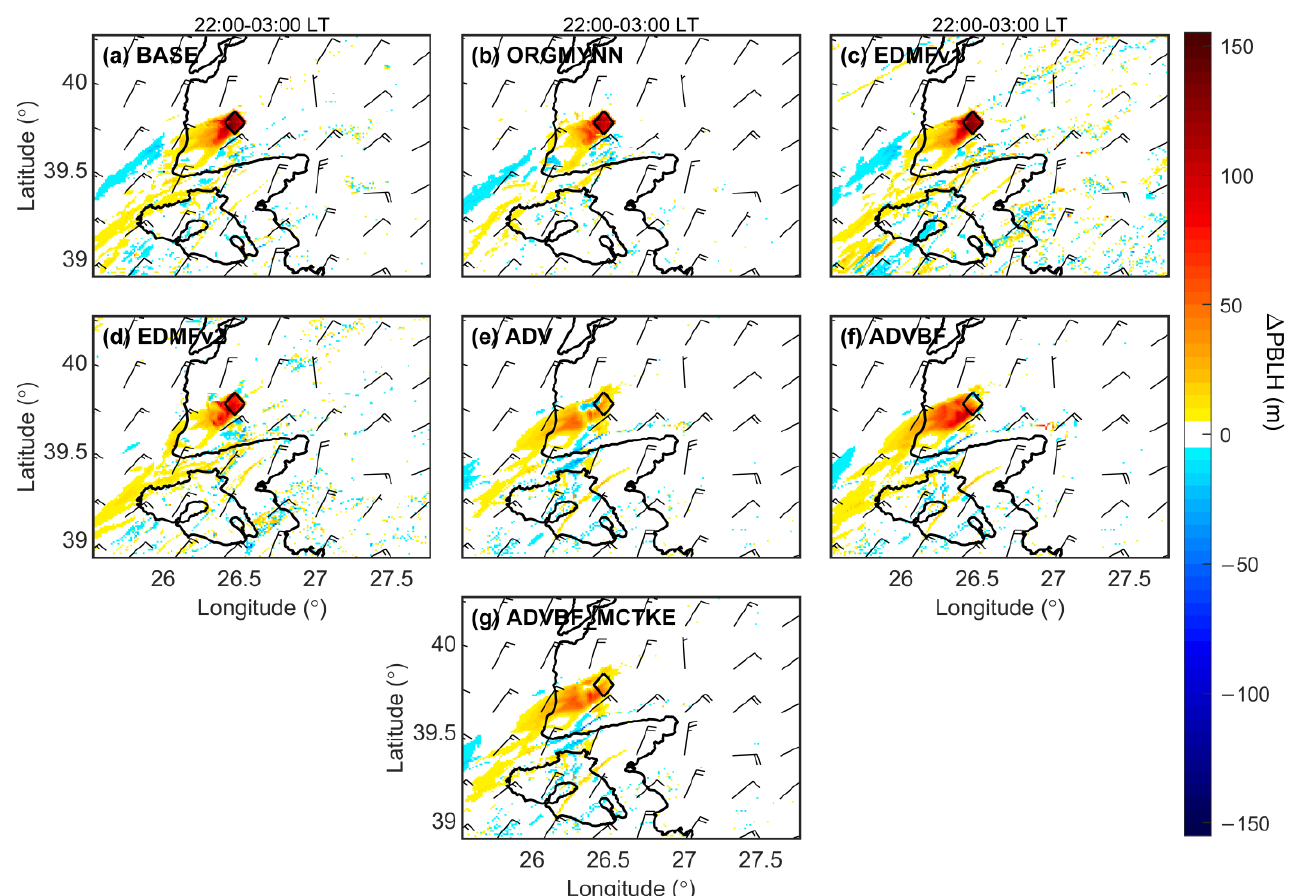
Figure 12. Same as in Figure 6, but for